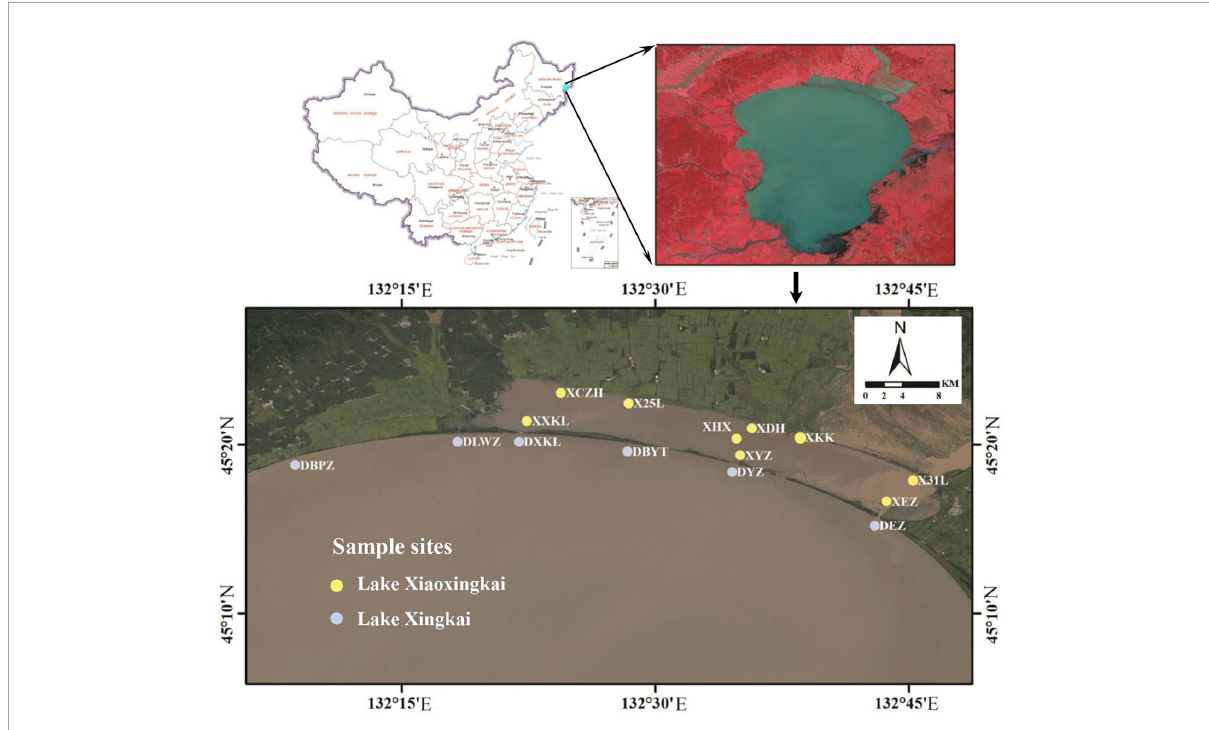
FIGURE1 Location of sampling sites in Xingkai Lake and Xiaoxingkai